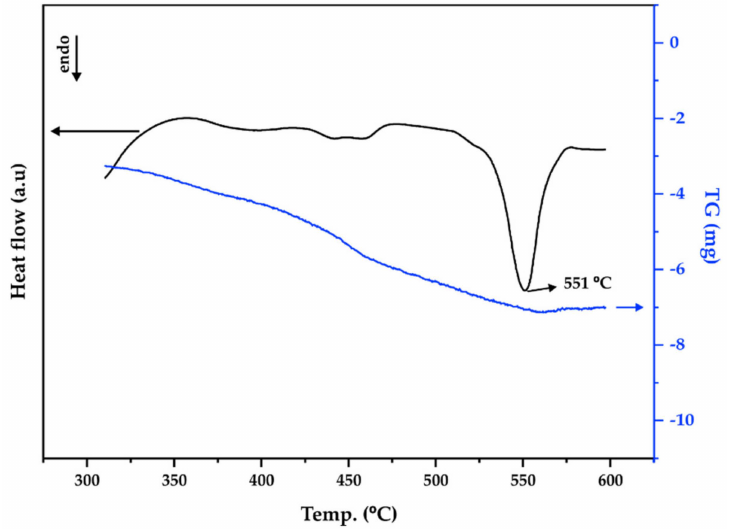
Figure 5. TG-DTA heating curves of mechanochemically synthesized CuSbS 2 powders (DTA—black curve, TG—blue